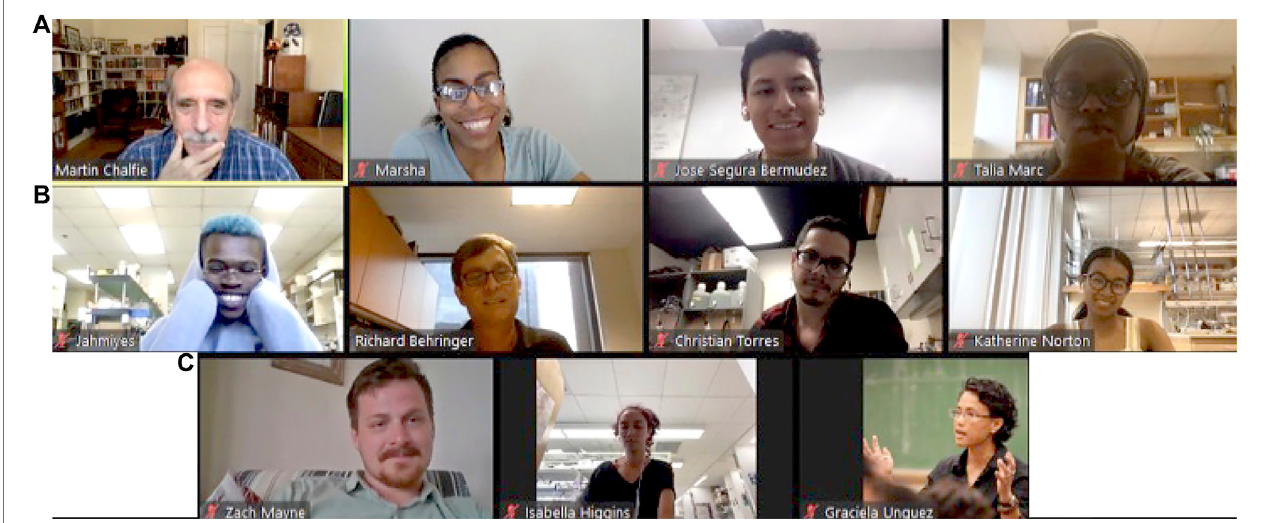
FIGURE 3 | Screen picture of a weekly Zoom meeting with 2021 Choose Development! Fellows and guest, former SDB President and Noble Laureate Dr. Martin Chal fi e. (A) Martin Chal fi e, Marsha Lucas (SDB Publications and Communication Director), Jose Segura Bermudez, and Talia Marc. (B) Jahmiyes Wright, Richard Behringer ( Choose Development! Program Coordinator), Christian Torres, and Katerine Norton. (C) Zach Mayne, Isabella Higgins, and Graciela A. Unguez ( Choose Development! Program Director).